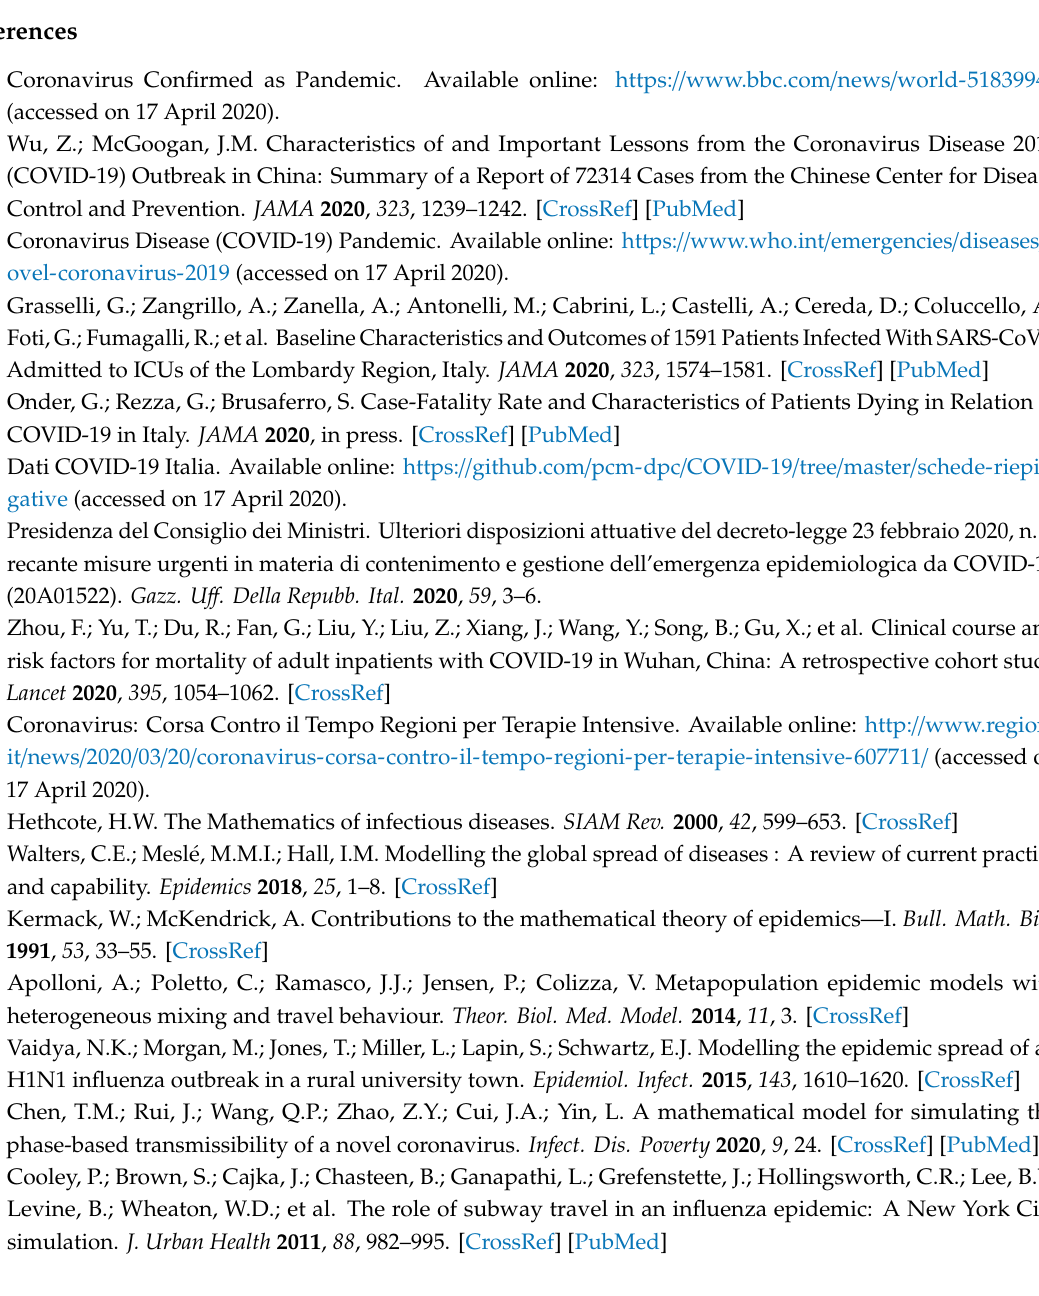
Figure S2: Emilia-Romagna’s COVID-19-associated hospitalizations, assuming that on day 0 (9 March 2020) there were 5 times as many undetected infected individuals ( A + I ) as known infected individuals ( H + L + D ), Figure S3: Lombardy’s COVID-19-associated hospitalizations, assuming that on day 0 (9 March 2020) asymptomatic cases ( A ) were one-third of the infected pool ( A + I ), Figure S4: Emilia-Romagna’s COVID-19-associated hospitalizations, assuming that on day 0 (9 March 2020) asymptomatic cases ( A ) were one-third of the infected pool ( A + I ), Figure S5: Lombardy’s COVID-19-associated hospitalizations under di ff erent values of the contact rate on day 0 (9 March 2020), Figure S6: Emilia-Romagna’s COVID-19-associated hospitalizations under di ff erent values of the contact rate on day 0 (9 March